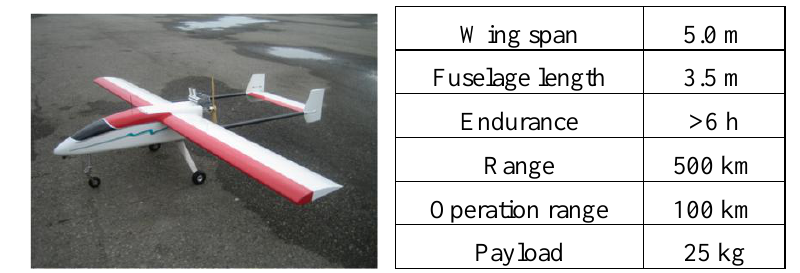
Figure 2. Proposed UAV